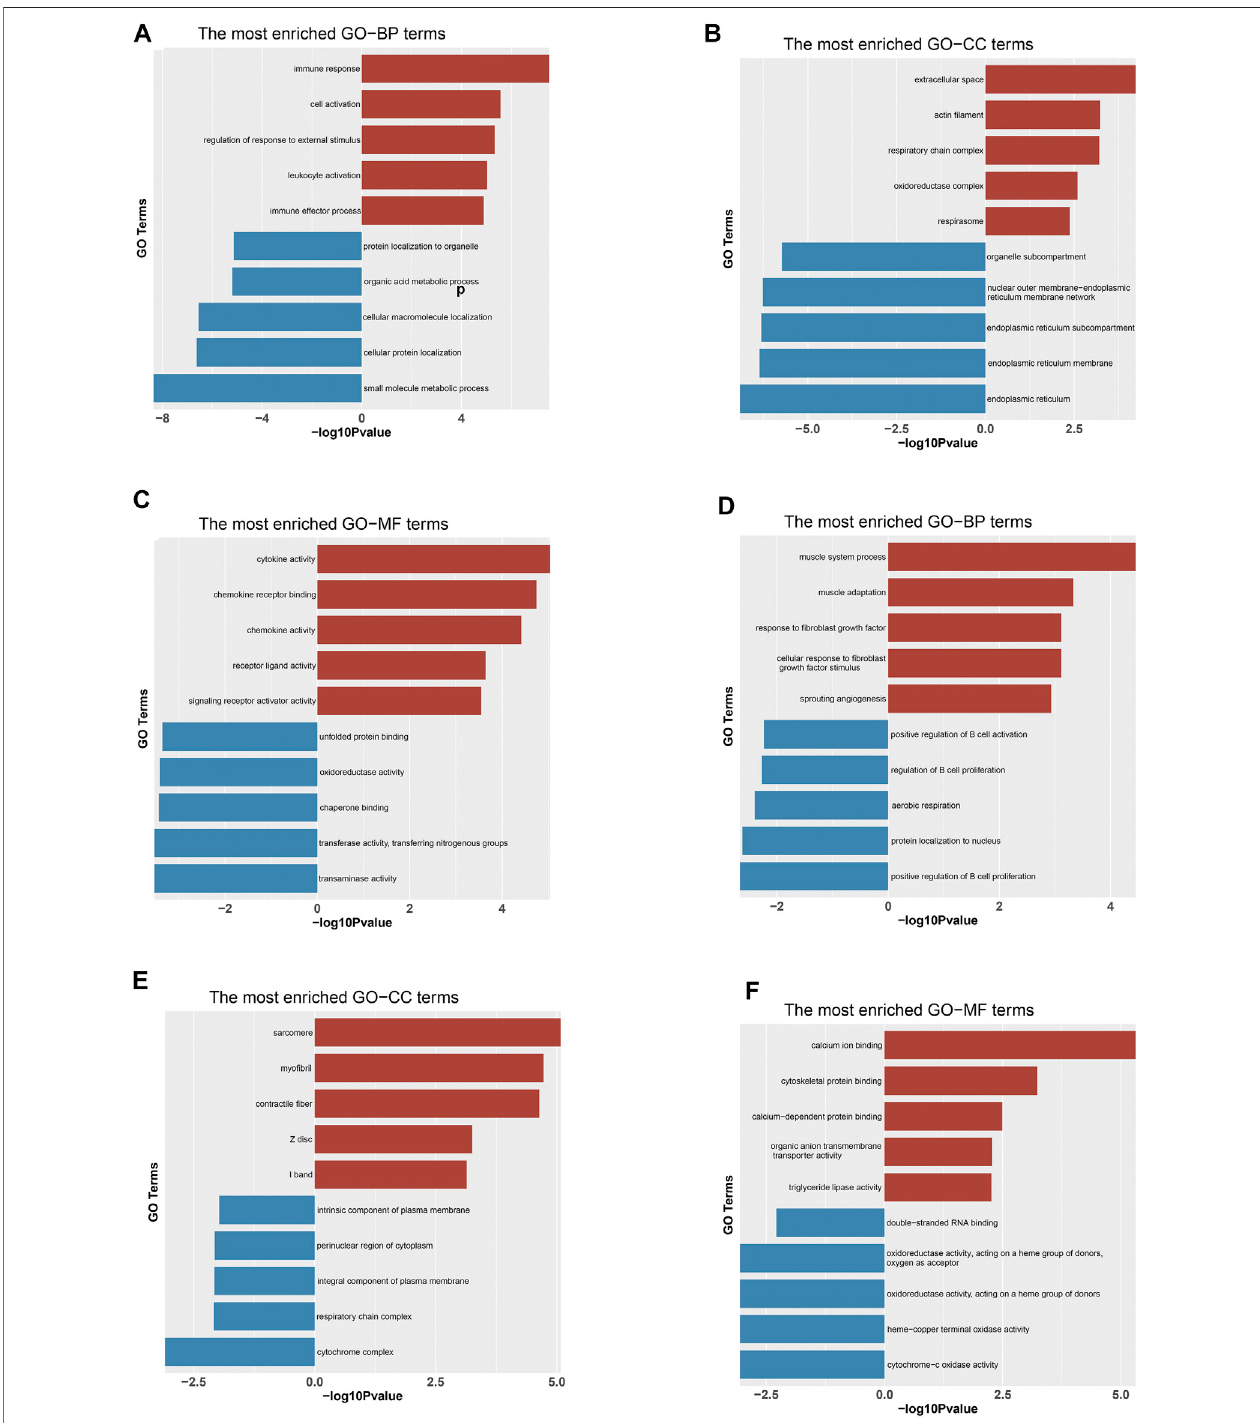
FIGURE 2 | Signi fi cantly enriched Gene Ontology (GO) terms of DEGs based on their functions. Bar chart of the top 10 BP (A) , CC (B) and MF (C) terms in the enrichment analysis of DEGs in the liv-er. Bar chart of the top 10 BP (D) , CC (E) and MF (F) terms in the enrichment analysis of DEGs in the muscle. BP: biological process; CC: cellular component; MF: molecular function. “ Red ” represents for GO terms of up-regulated genes and “ Blue ” represents for GO terms ofdown-regulated genes in DP.